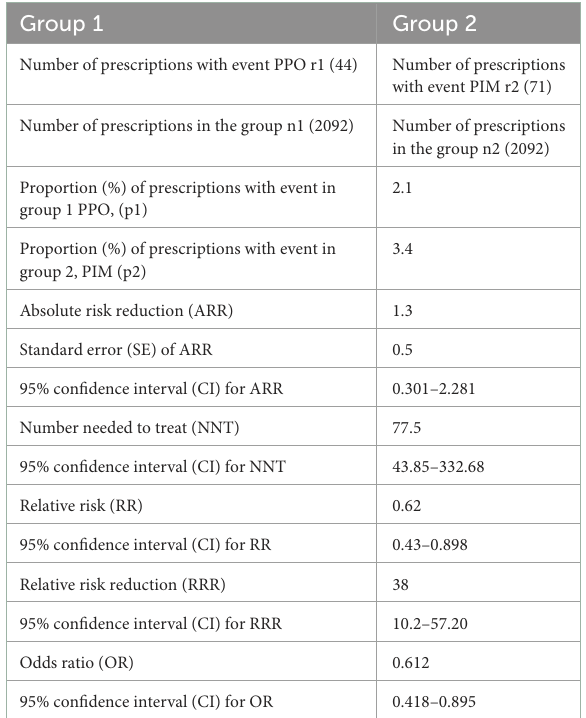
TABLE 6 Risks for development of PIMs, and PPOs for the observed prescriptions. Group 1